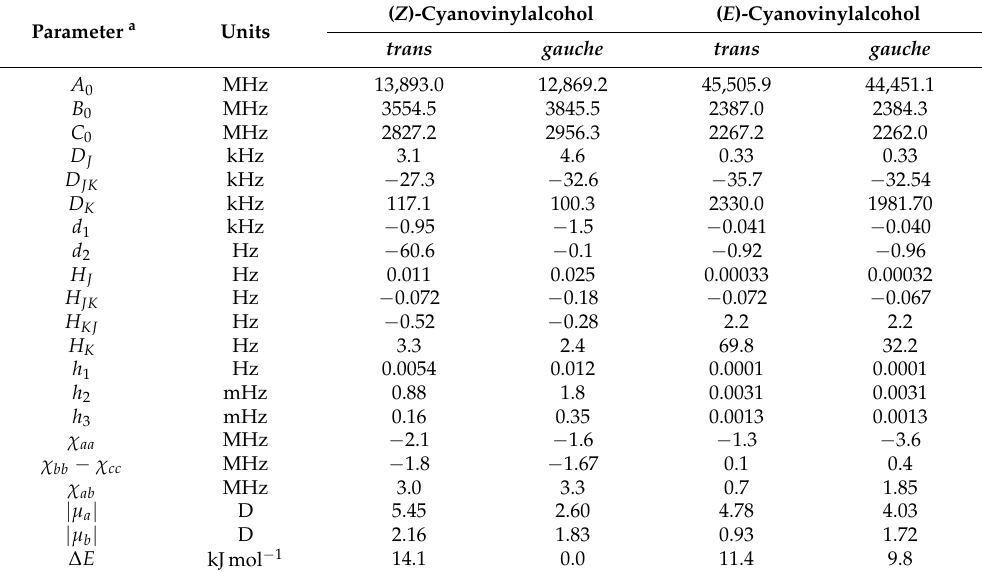
Table 2. Computed rotational parameters for the ( E )- and ( Z )-cyanovinylalcohol forms and their relative